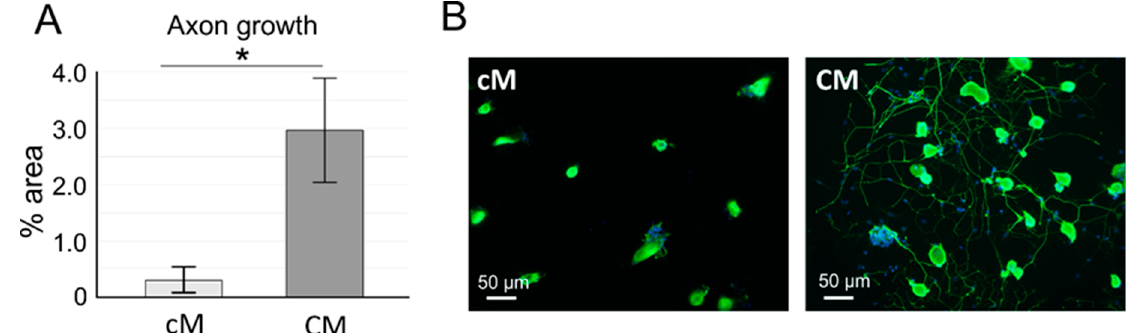
Figure A1. The effect of WJ-MSC-derived CM on neurite growth of rat dorsal root ganglia (DRG) neurons. ( A ) The area (%) of beta III tubulin positive staining in the presence of conditioned (CM) and non-conditioned (cM) medium ( n = 3 in duplicates, * p < 0.05). ( B ) DRG neurons cultured in the presence of control and conditioned or medium (beta III tubulin/DAPI staining).